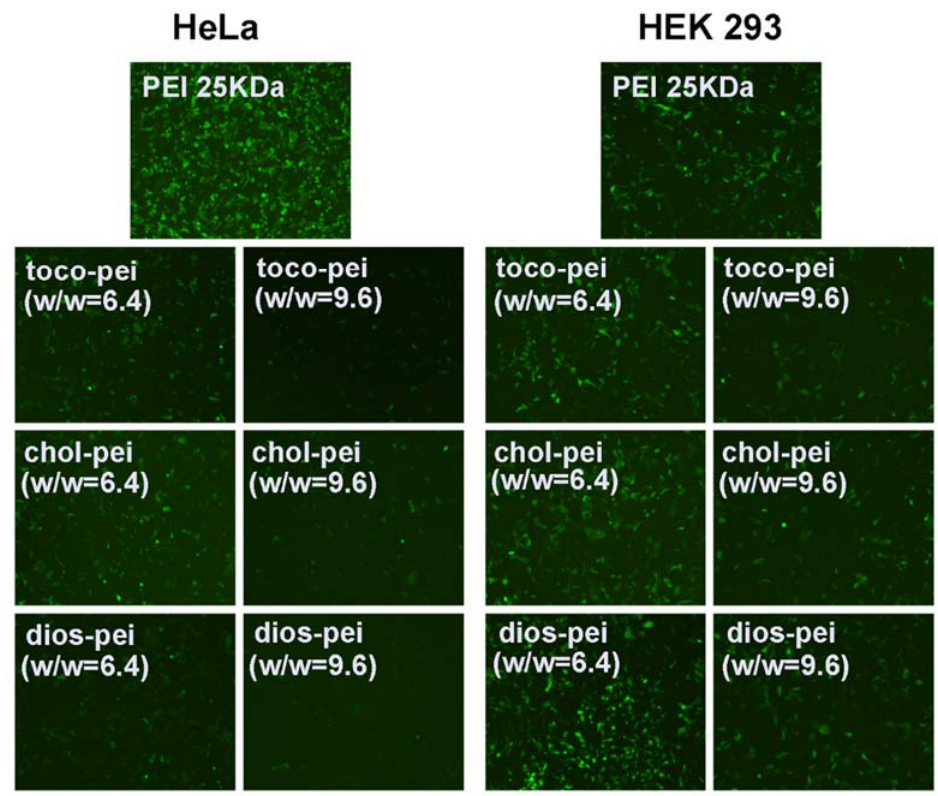
Figure 8. Images of pEGFP-transfected HeLa and HEK293 cells with a serum-free medium at different weight ratios ( w / w = 6.4 or 9.6); 25-kDa PEI was used for comparison.